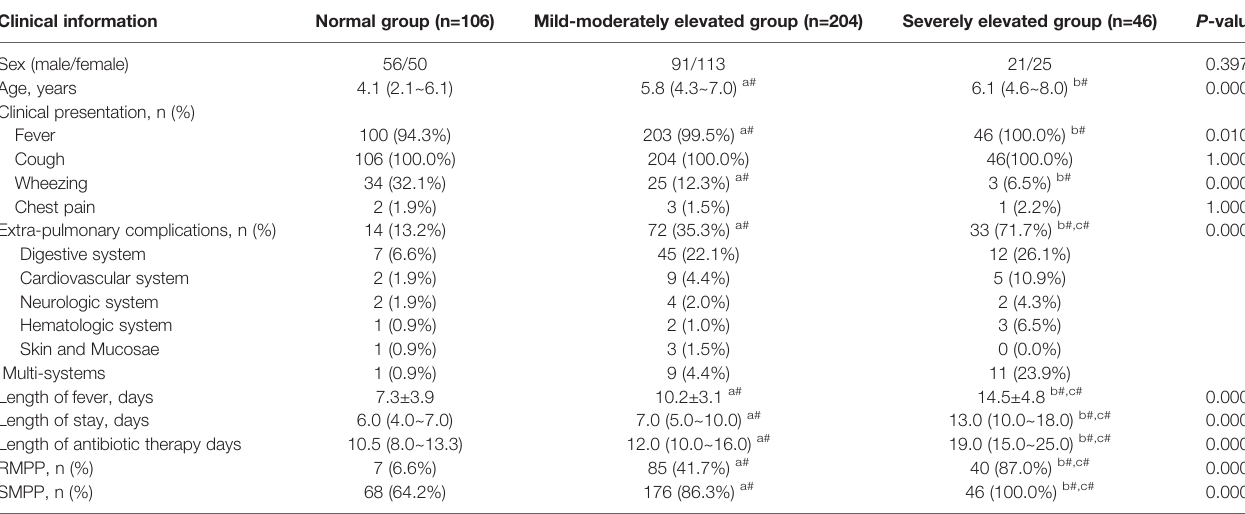
TABLE 1 | Demographic and clinical characteristics of patients with MPP. Clinical information